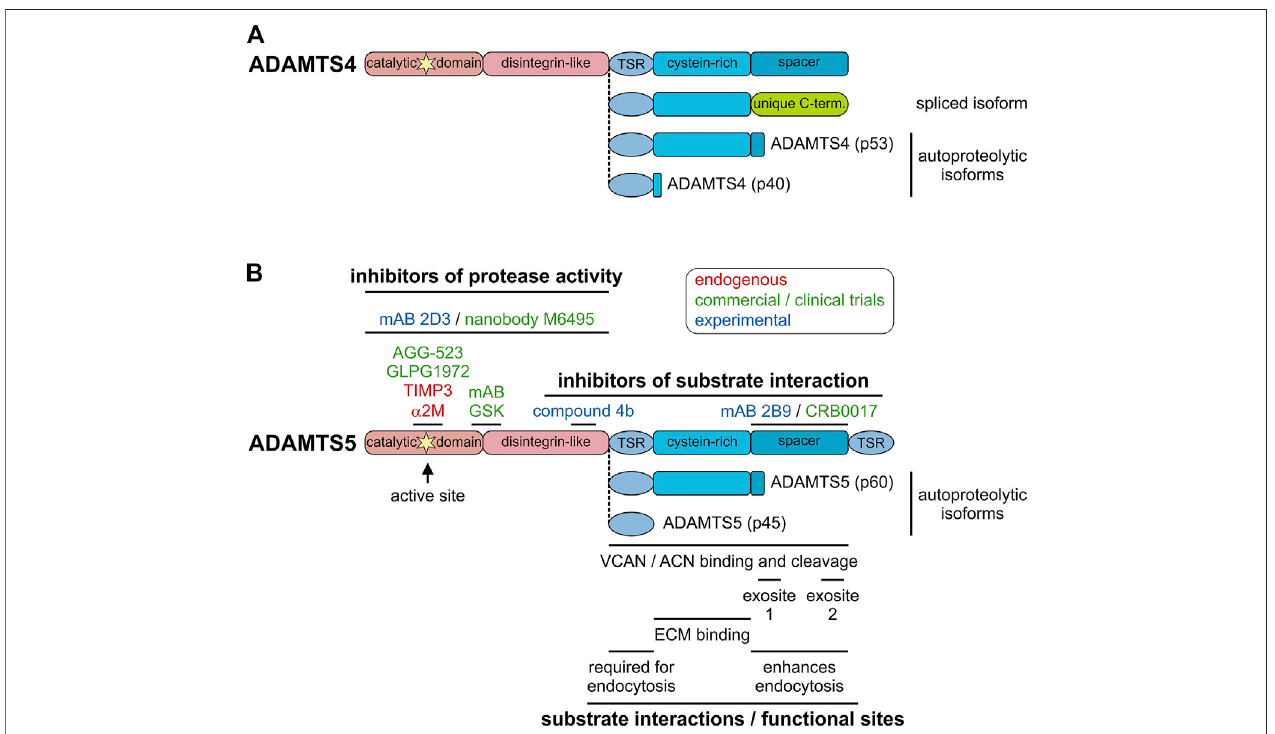
FIGURE 3 | Endogenous and pharmacological inhibitors of ADAMTS proteases. (A) Domain organization of furin-processed mature ADAMTS4 and the organization of the ancillary domain of spliced and autoproteolytic isoforms showing the similarity to ADAMTS5 and its isoforms. (B) Domain organization of furin- processed mature ADAMTS5 depicting the location of endogenous and pharmacological inhibitor epitopes (top) and relevant functional and substrate interaction sites of ADAMTS5 (bottom) . The ancillary domains of theautoproteolytic isoformsp60 and p45 aredepicted.Endogenous inhibitors are indicatedin red, inhibitors that went through clinical trials or are in commercial product pipelines are indicated in green and experimental inhibitors reported in the literature are indicated in blue.